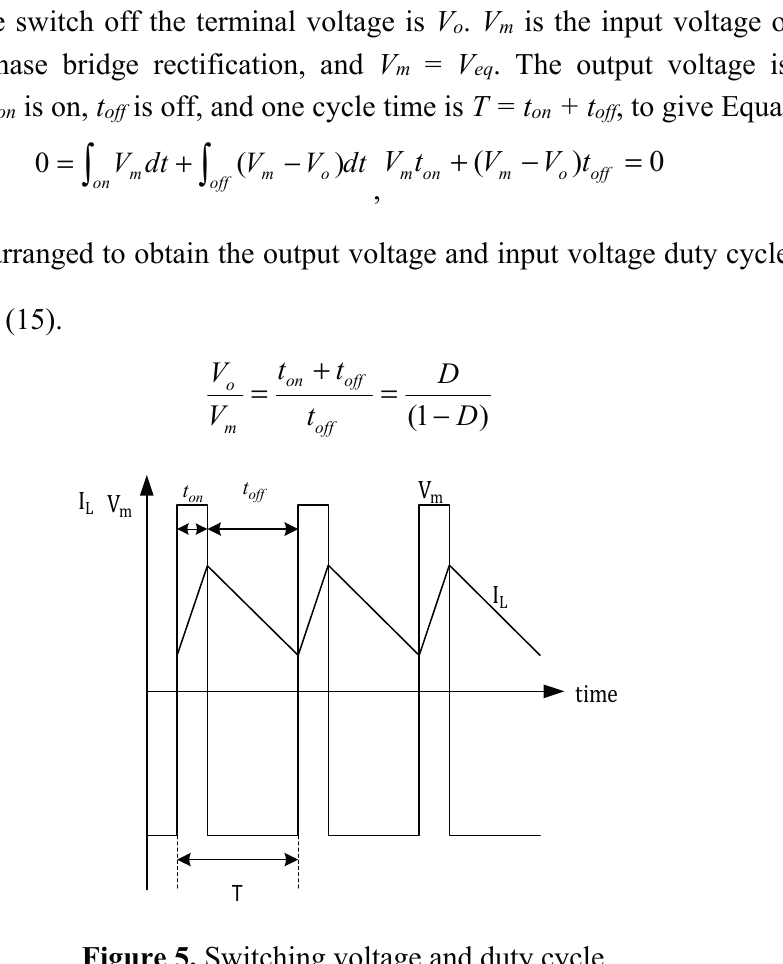
Figure 5. Switching voltage and duty